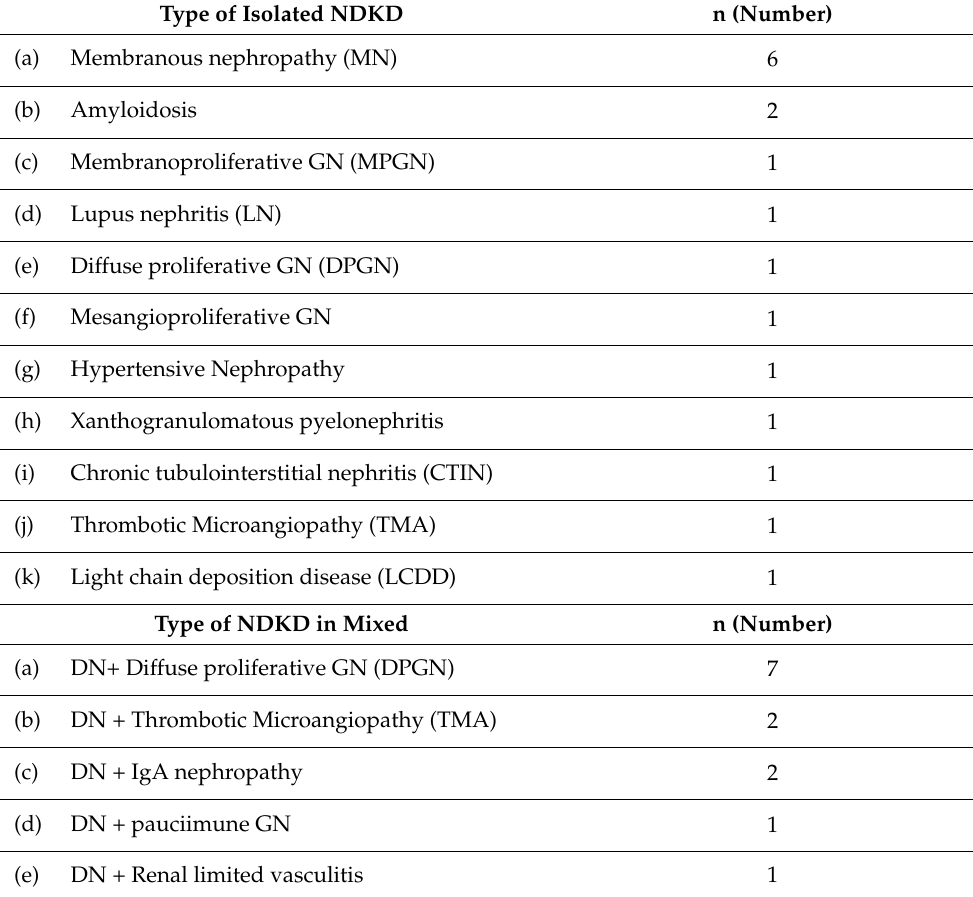
Table 3. Heterogeneity of NDKD in patients with type 2 diabetes mellitus patients (n = 30).